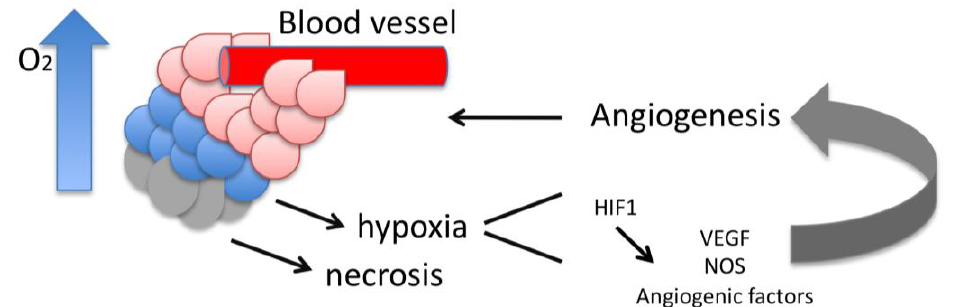
Figure 3. Role of hypoxia in tumor